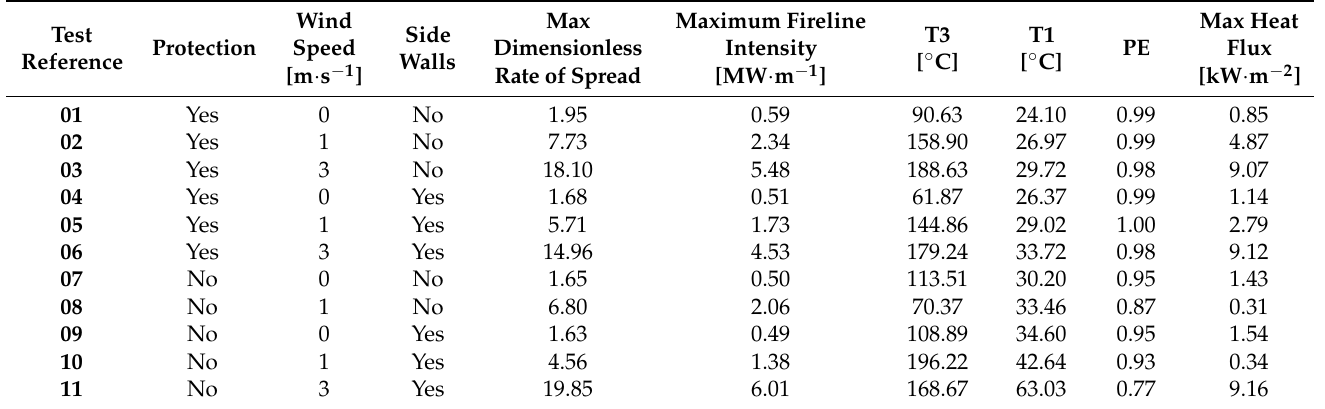
Table 3. Main results of the tests